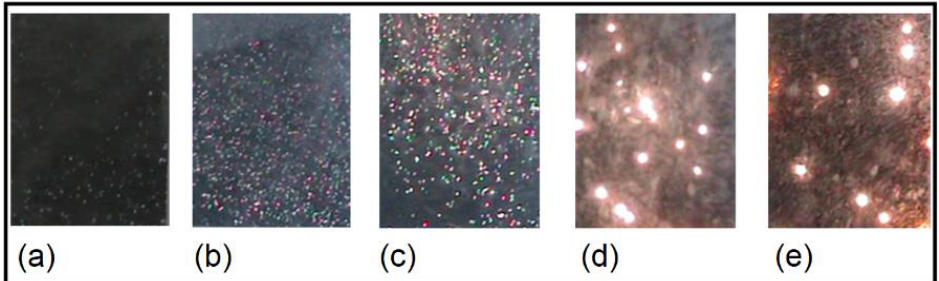
Figure 2. MDs appearance at various stages of tantalum anodization: ( a ) 10 s; ( b ) 150 s; ( c ) 300 s; ( d ) 600 s; ( e ) 900 s.